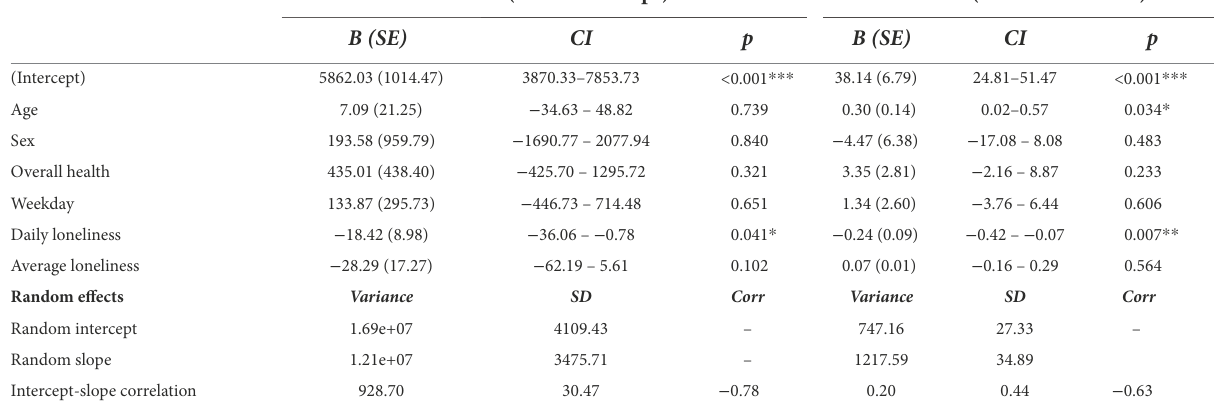
TABLE 2 Results from multilevel models examining loneliness and physical activity ( N = 139).